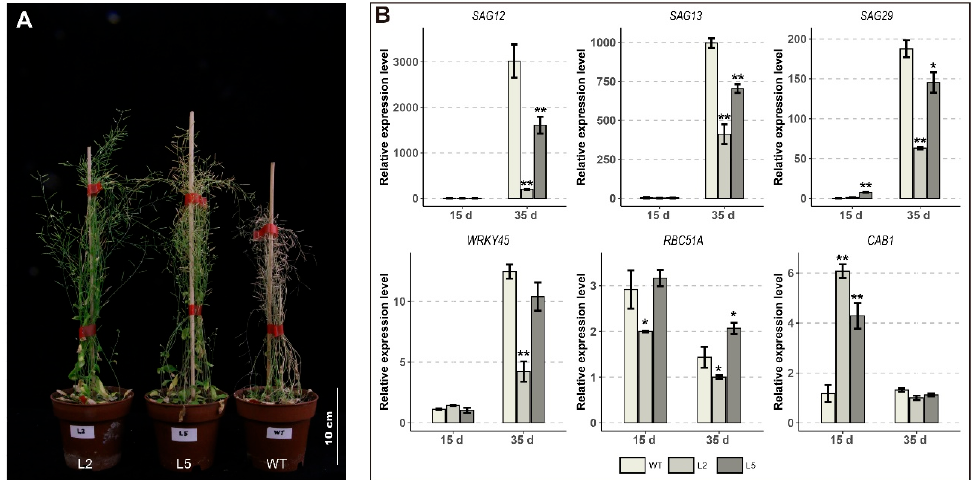
Figure 7. Phenotypic characteristics of transgenic plants at the senescence stage. ( A ) Differences in the senescence phenotype of WT and transgenic plants in the late growth period. ( B ) Relative expression of senescence-related genes in WT and transgenic plants. Each experiment was repeated three times, with the bar representing the standard error (SE). Asterisks indicate a significant difference from the WT plants at p < 0.05 or p < 0.01 as determined by Bonferroni’s